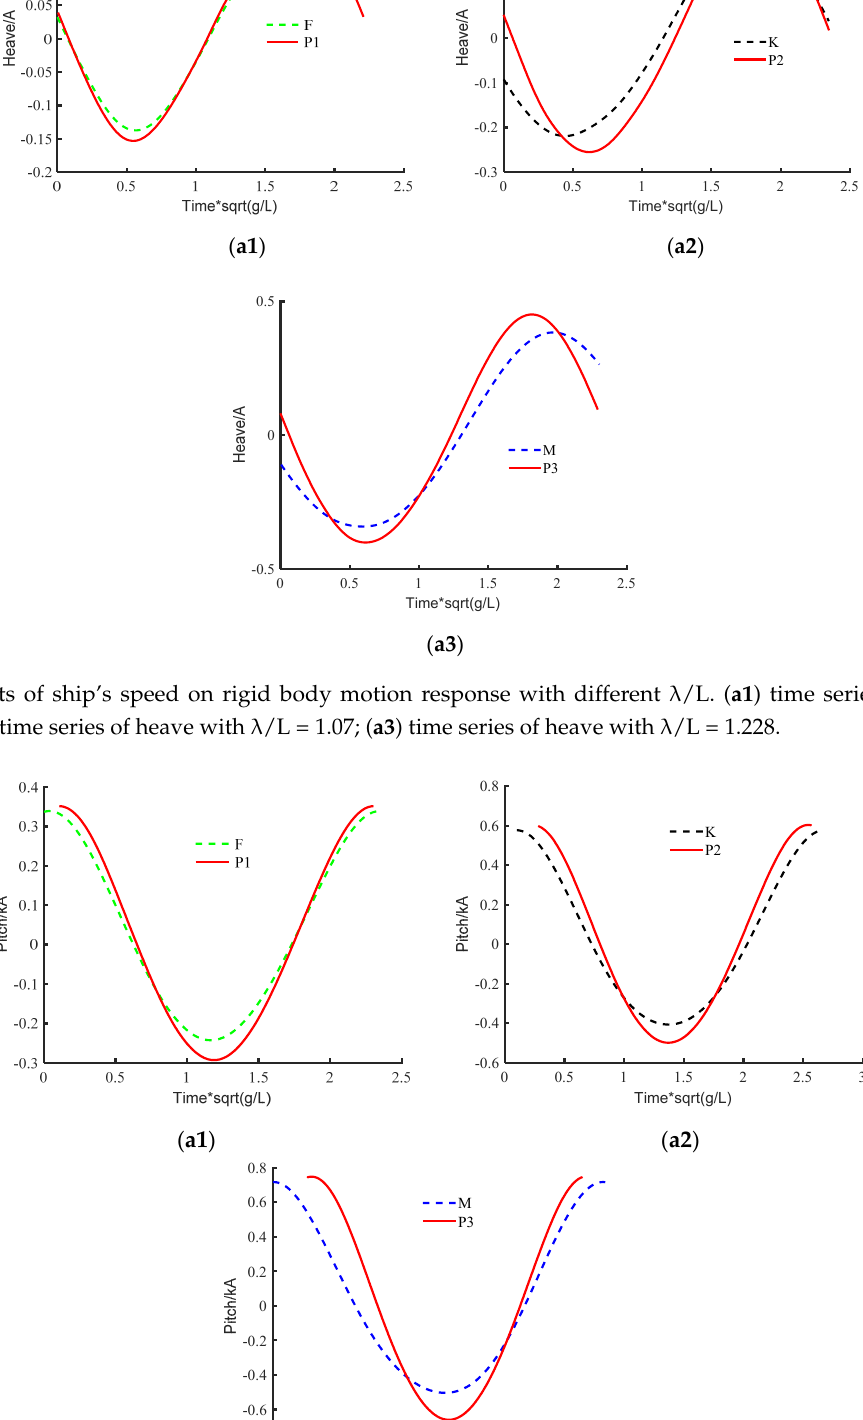
M P3 ( a3 ) Figure 13. Effects of ship’s speed on hydroelastic response with different λ /L. ( a1 ) time series of VBM4 with λ /L=0.857; ( a2 ) time series of VBM4 with λ /L=1.07; ( a3 ) time series of VBM4 with λ /L=1.228. 4.2.2. Quantitative comparison of the nonlinear factors’ effects The non-linearity of the hydroelastic response due to the wave non-linearity, i.e., the wave steepness, are quantitatively investigated in this section. The parameters of the simulations are shown in Table 8. Table 8. The simulation conditions for case L1–L3 and H1–H3.